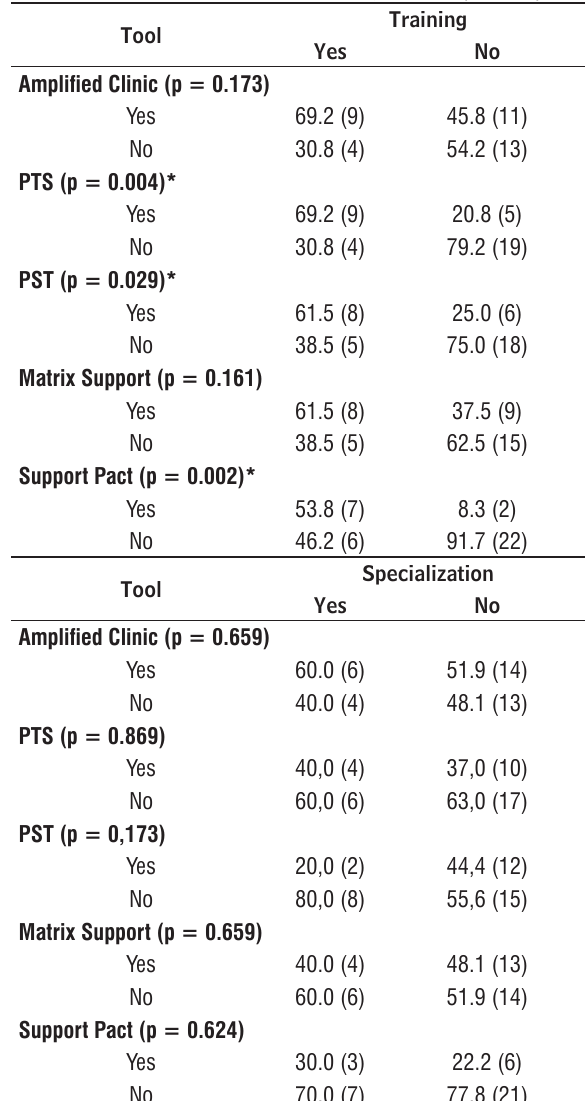
Table 5 - Association between training/specialization,